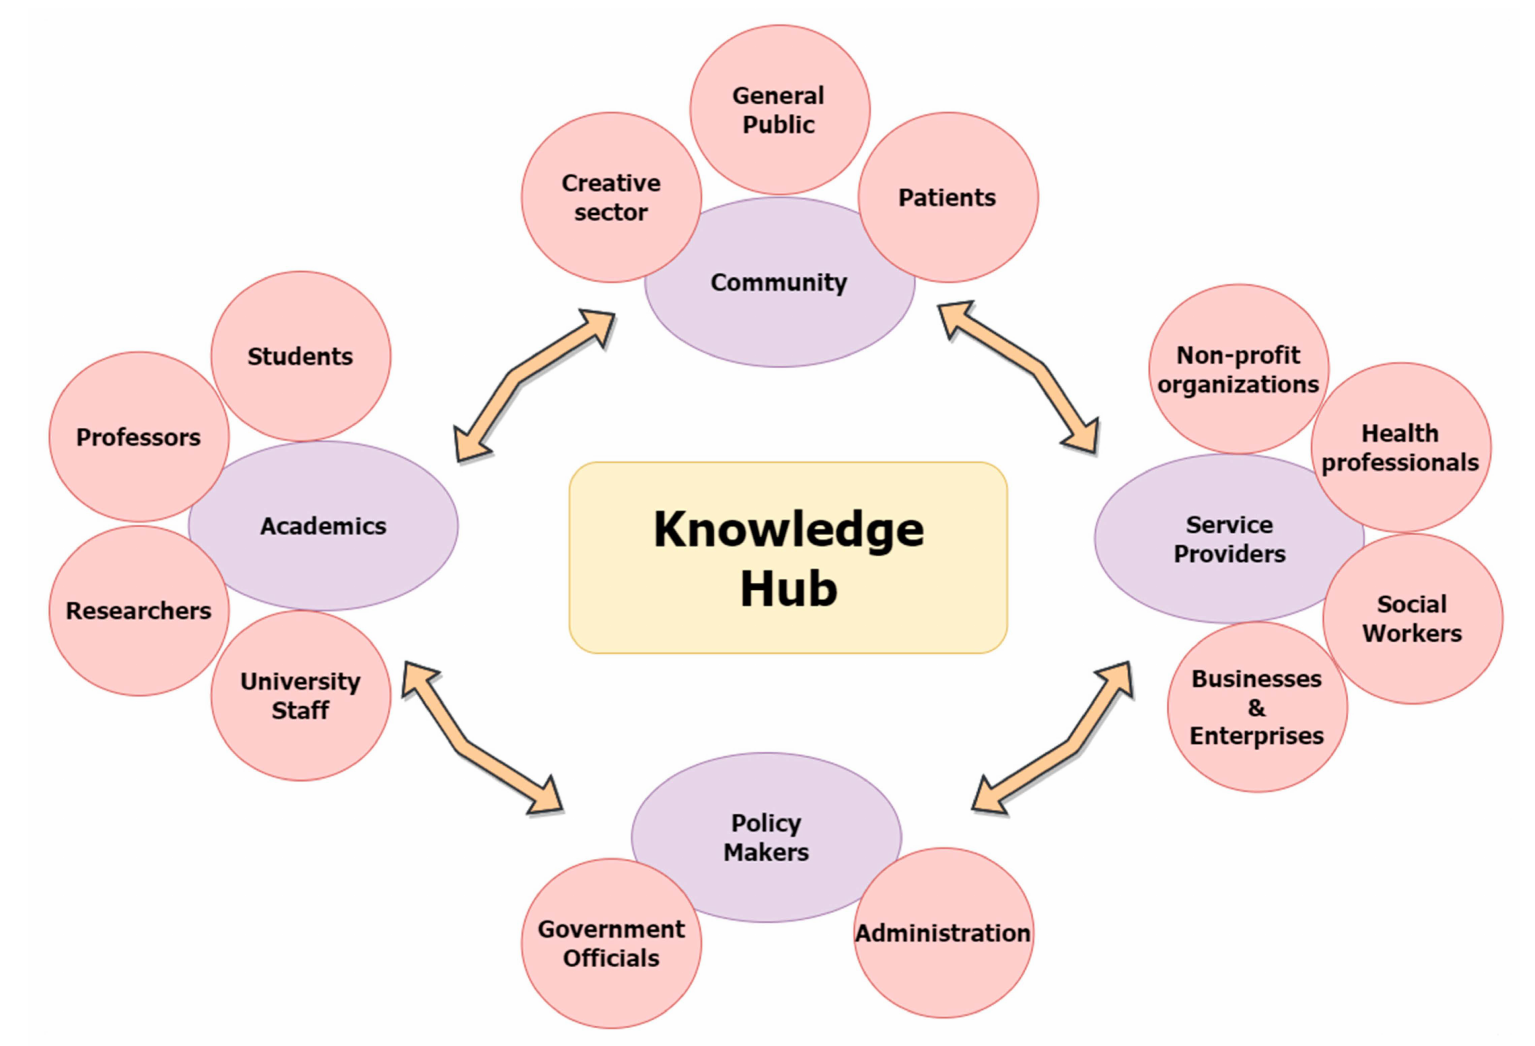
Figure 3. Stakeholders collaborating in knowledge